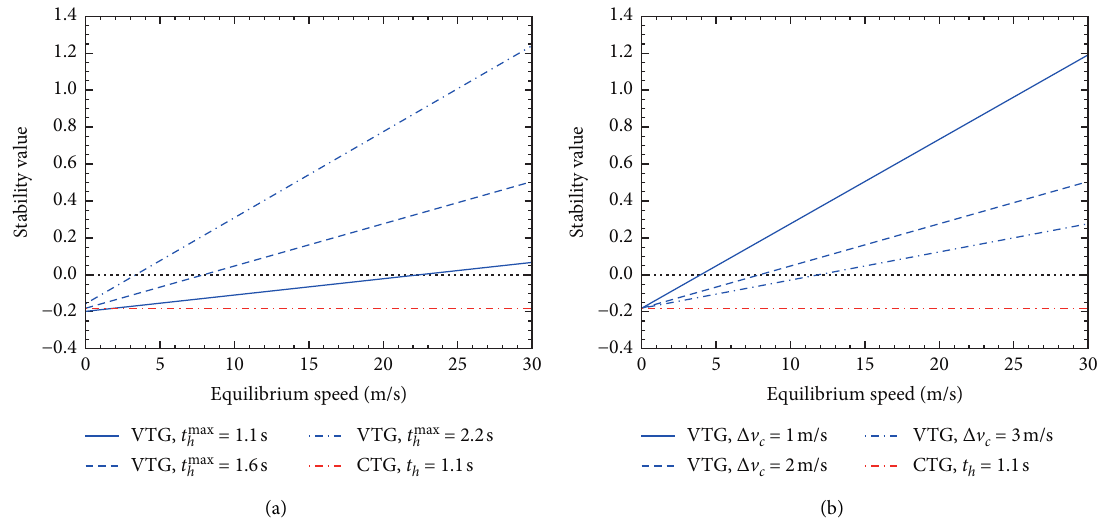
Figure 3: Stability of homogeneous ACC vehicles with different desired time gap policies. (a) Effect of t max